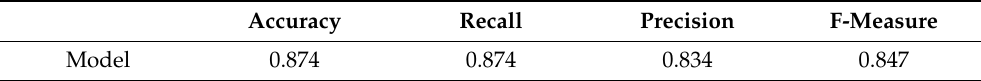
Table 4. Neural network classification model training results.